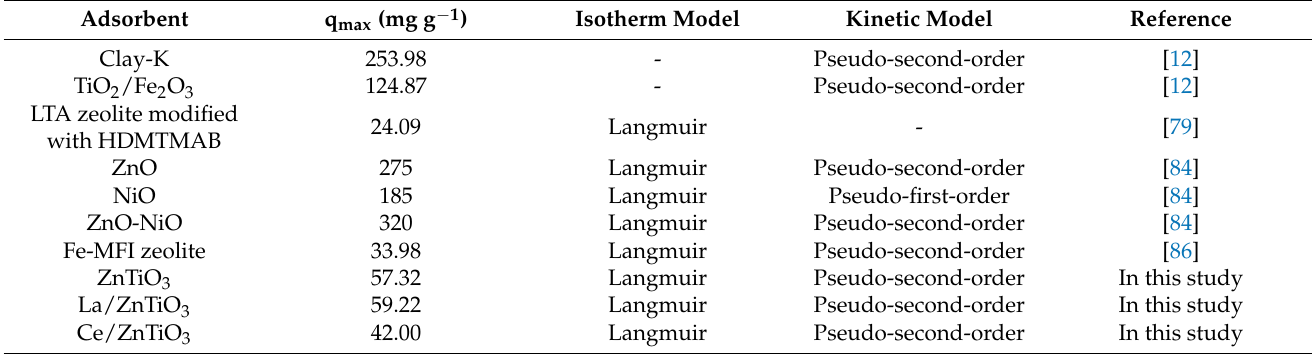
Table 4. Comparison of the adsorption capacity (mg g − 1 ) of various materials for cyanide removal.